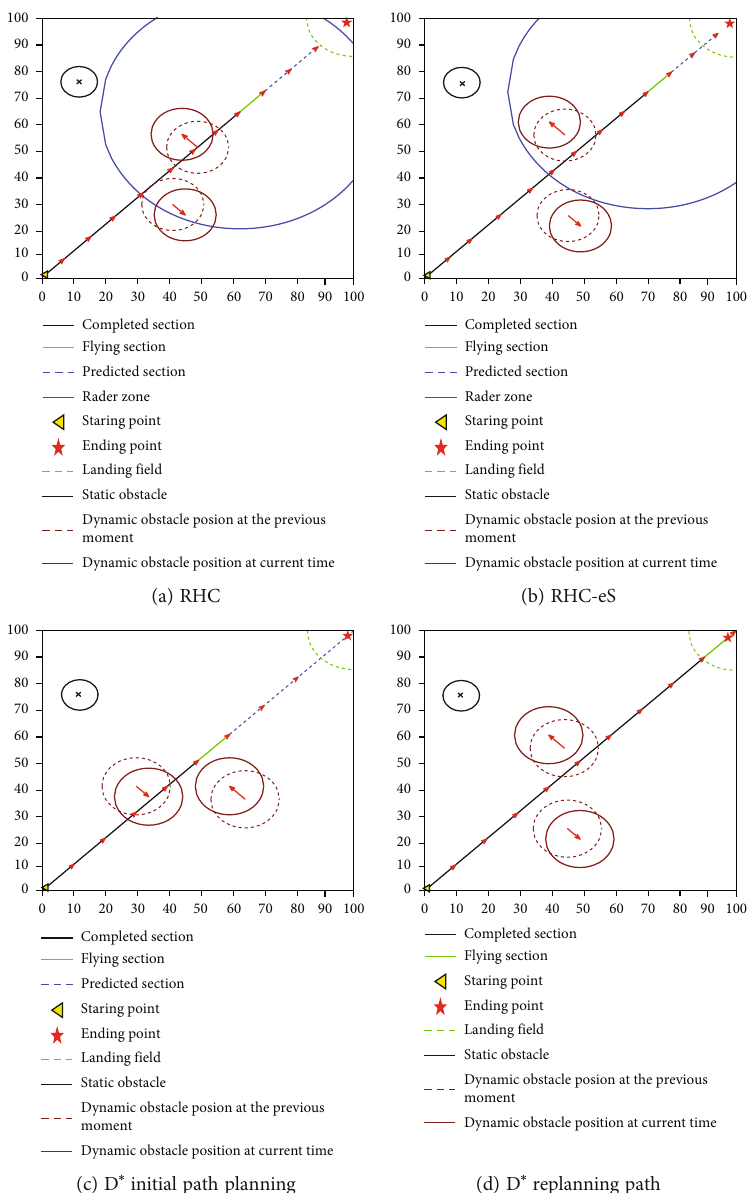
Figure 7: Environmental case 3 path planning